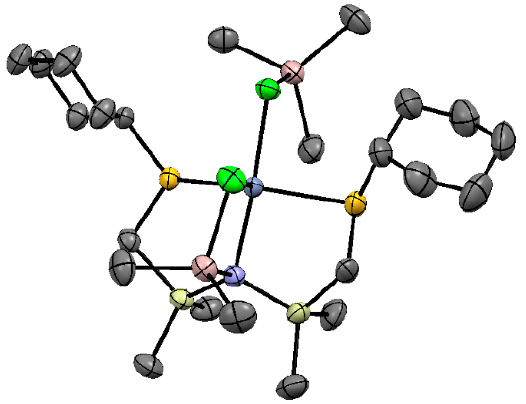
Figure 35. Molecular structure of complex Cr18 [253].